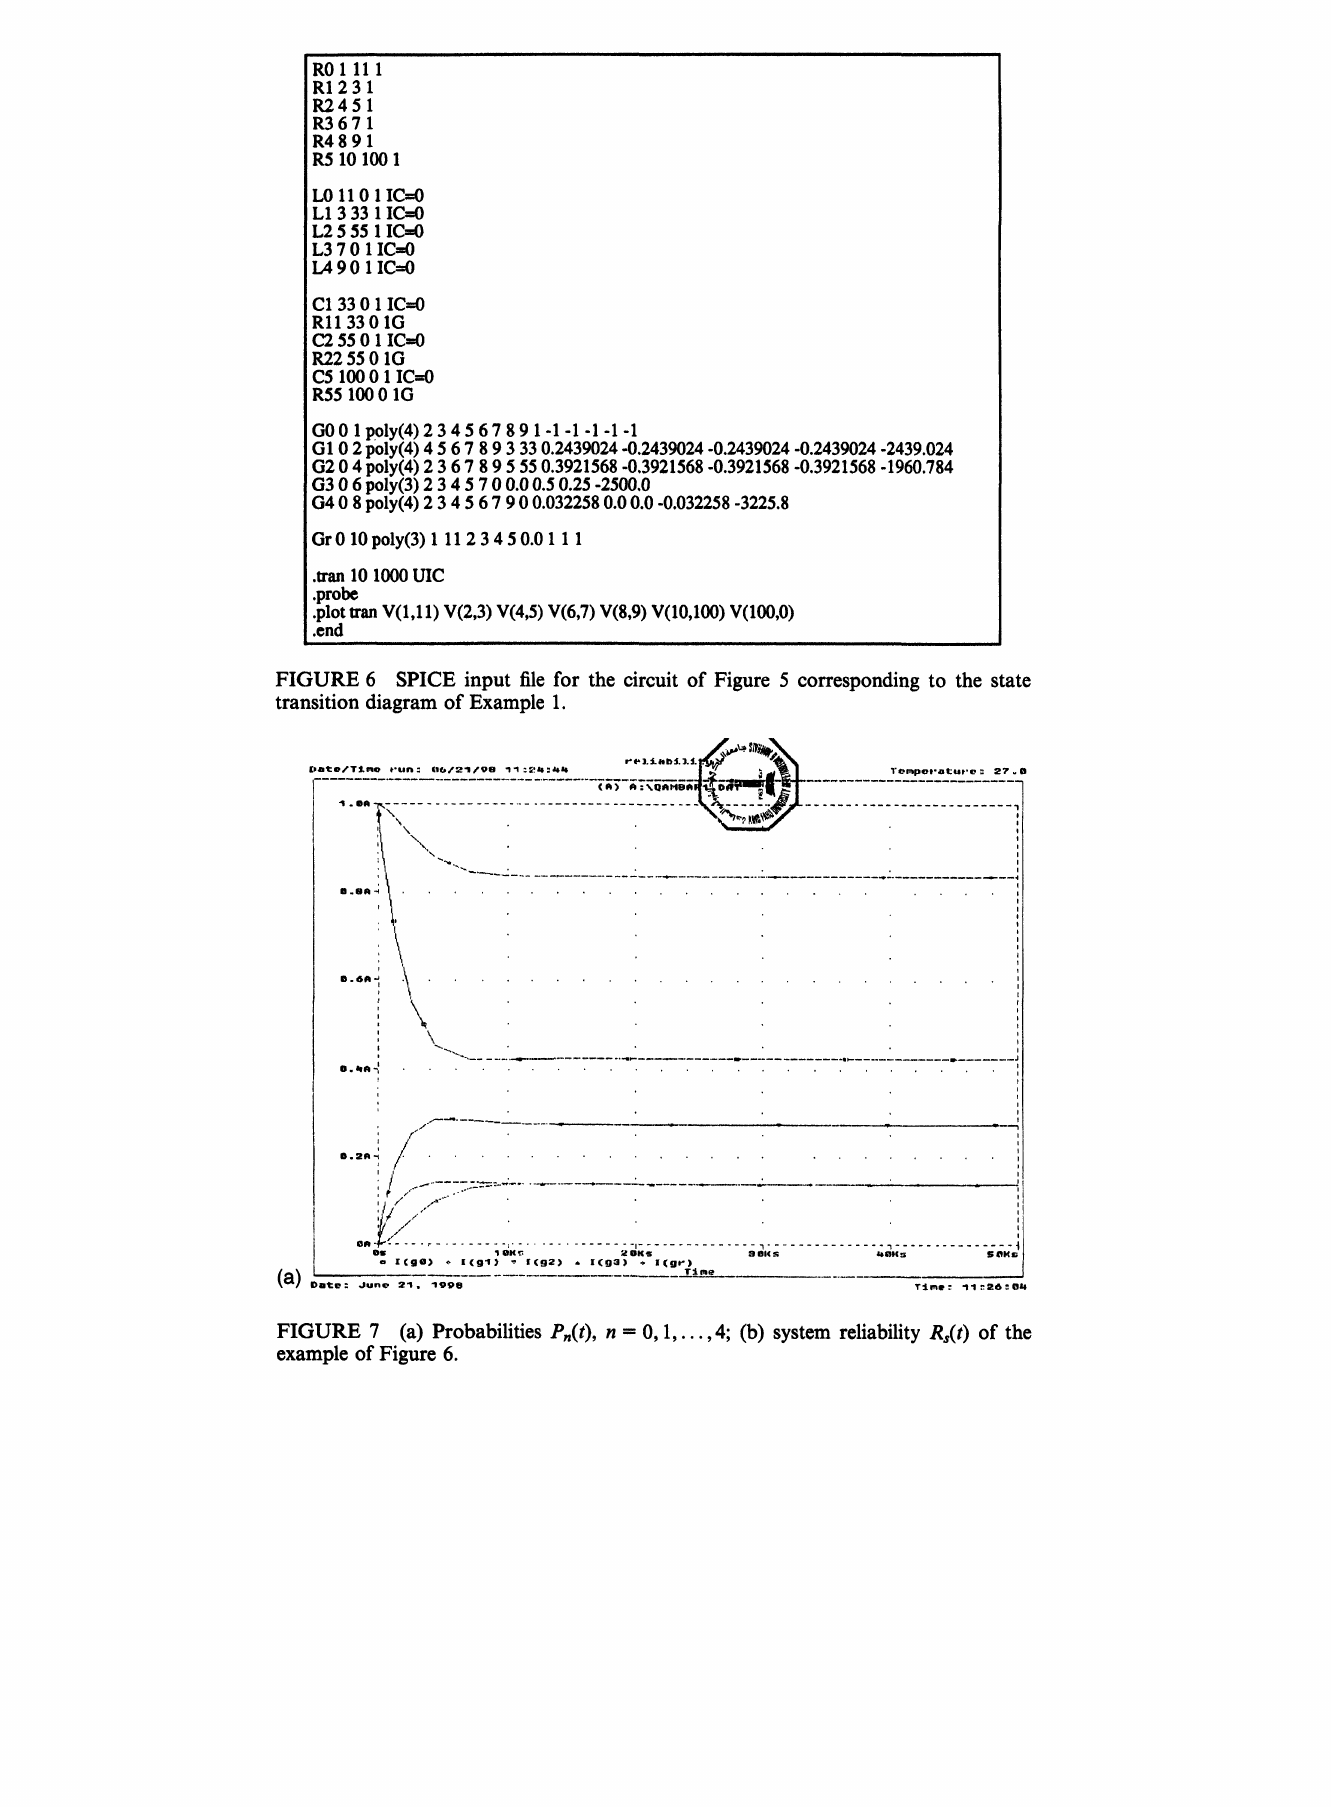
FIGURE 7 (a) Probabilities P,,(t), n--0,1 4; (b) system reliability Rs(t) of the example of Figure